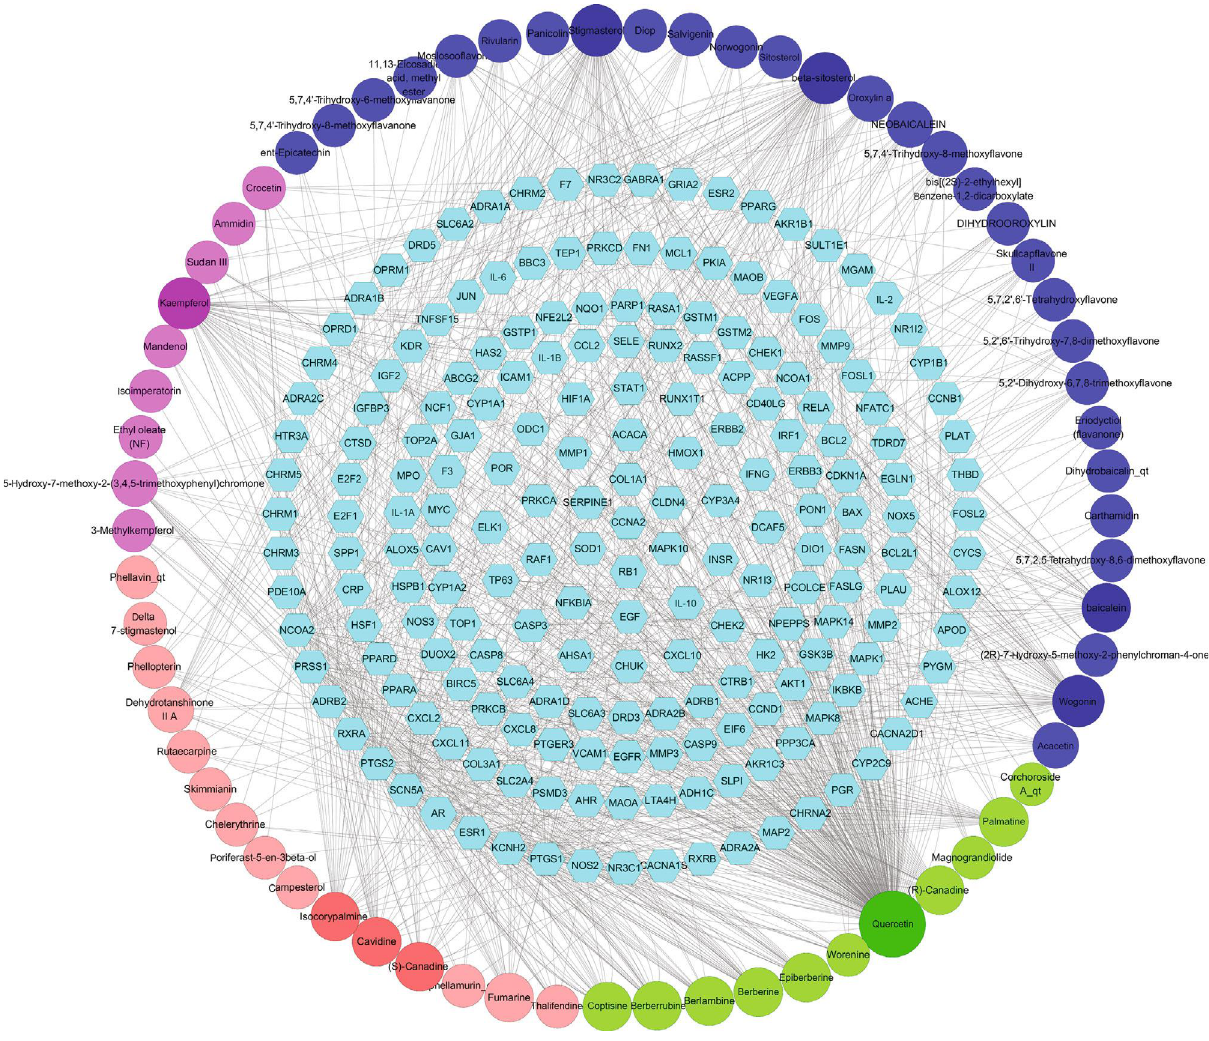
Figure 3: Network of active components-targets. 203 human-derived target proteins target nodes represented by light blue hexagon. Green, dark blue, red, and purple circles employed to stand for compounds of HL, HQ, HB, and ZZ,